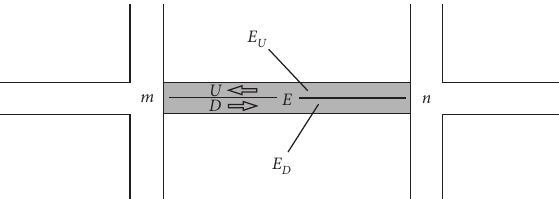
Figure 3: This image indicates a shared link between two inter- sections. Link E is the shared link for adjacent junctions n and ( m ). This common link is presented in (1) as Nv e i . ED is the destination link of intersection m and origin link of intersection ( n ), but EU is the destination and origin of intersections n and ( m ), respectively. The intersection matrices of junctions m and n , IMm and IMn,